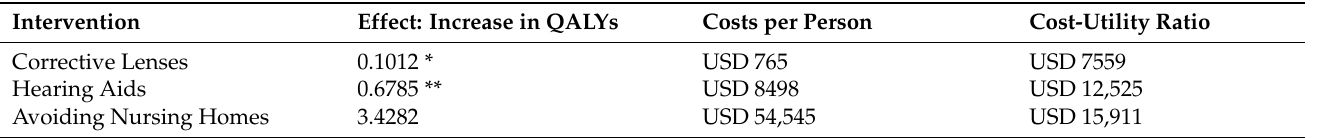
Table 2. Cost-Utility Analysis of Various Dementia